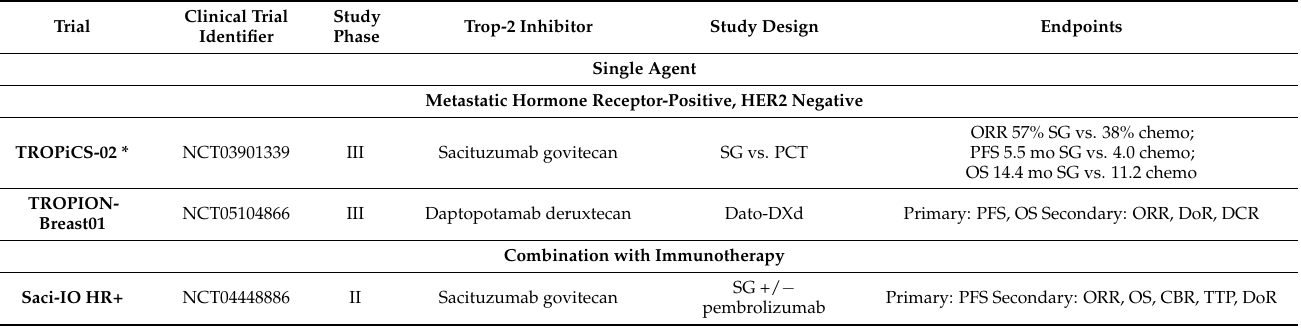
Table 3. Ongoing and completed clinical trials involving Trop-2 inhibitors in metastatic hormone receptor-positive, HER2 negative breast cancer as single agents and in combination with